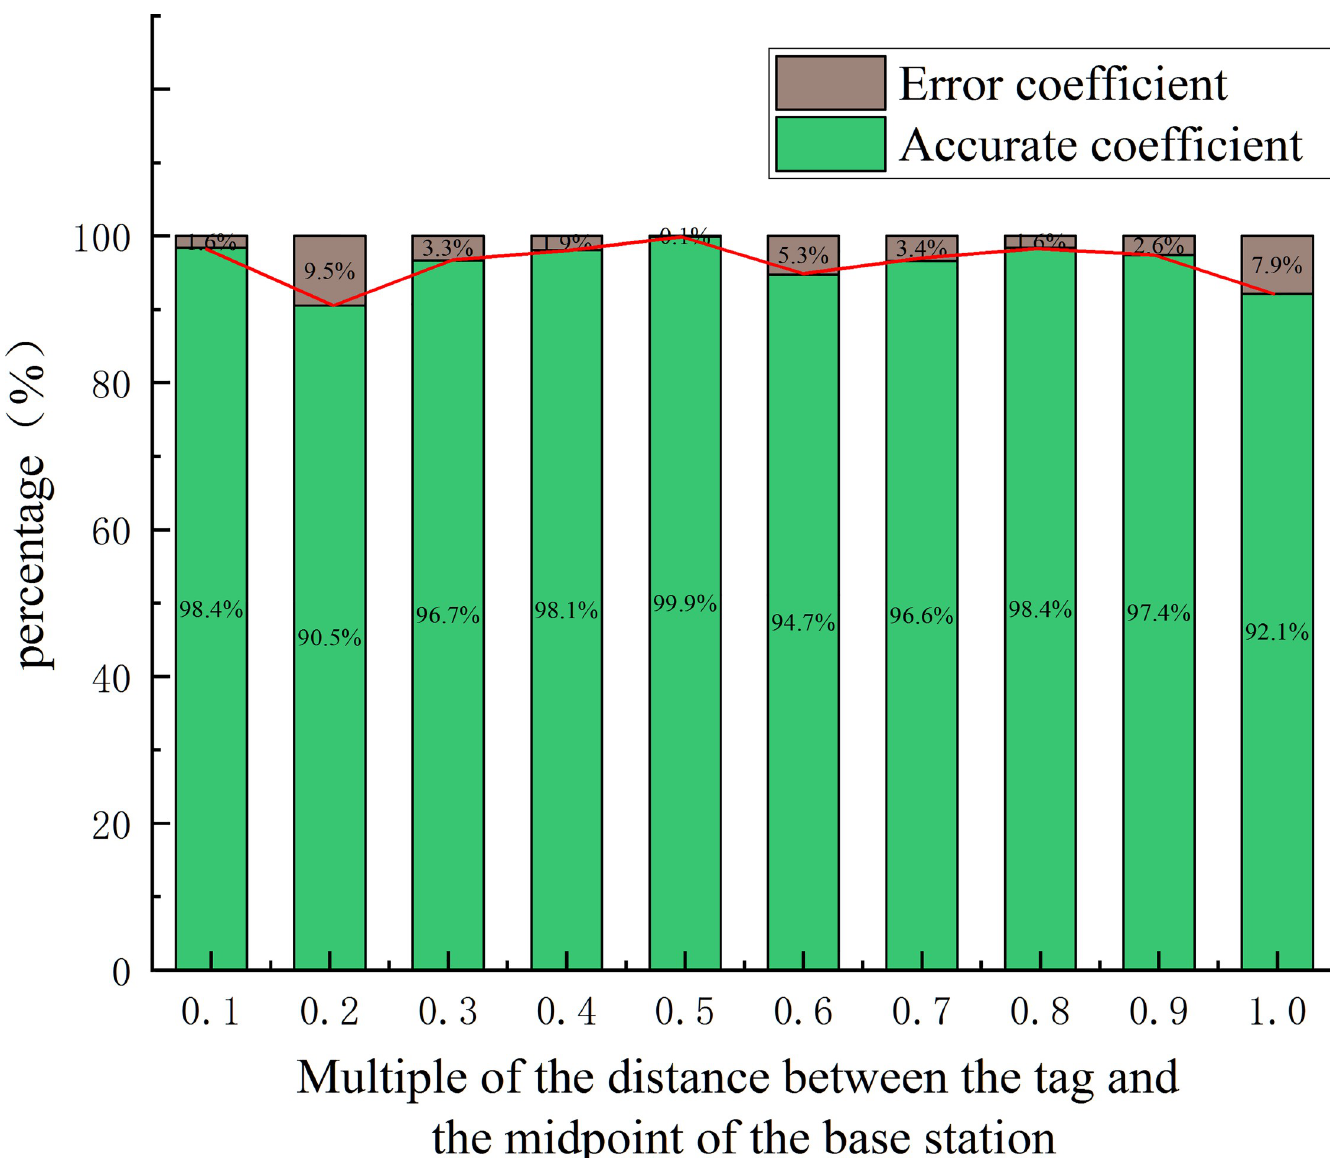
Fig 7. Error in experiment